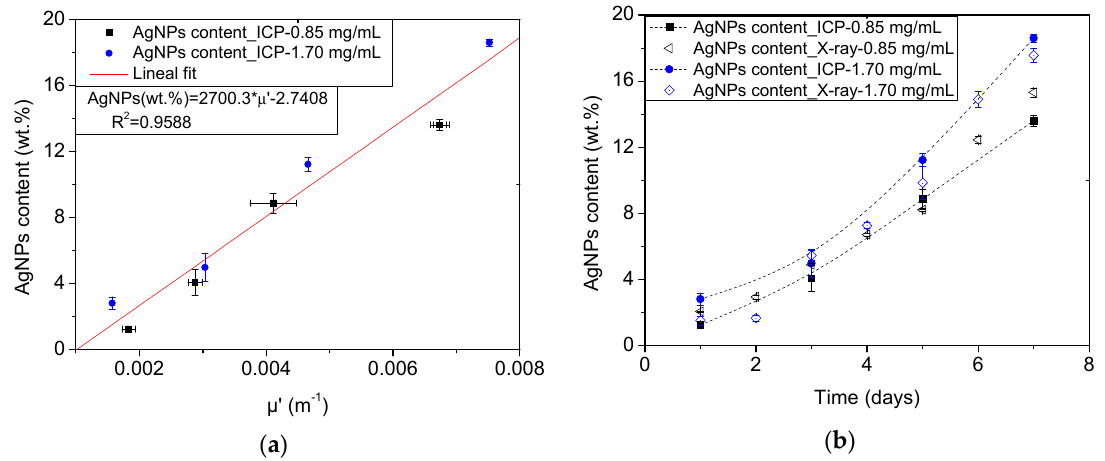
Figure 8. Calibration curve relating the AgNPs content (wt.%) reference values obtained by ICP-OES [10] and the μ ’ measured on the ME/Ag foams. The obtained calibration equation is shown in an inset ( a ). AgNPs content (wt.%) of all ME/Ag foams calculated from the measured μ ’ and using the previous calibration. Trends of the reference values from ICP-OES measurements are shown in dotted lines for comparison purposes ( b ).